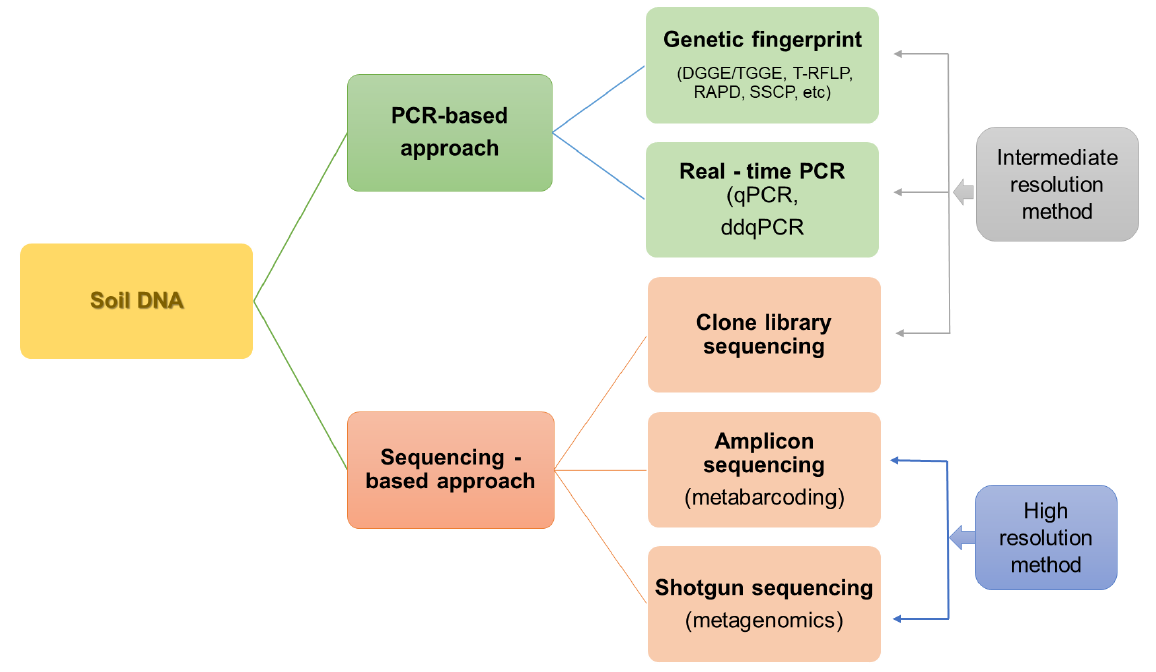
Figure 2. The main methods of studying the diversity and structure of soil microorganisms based on DNA analysis.